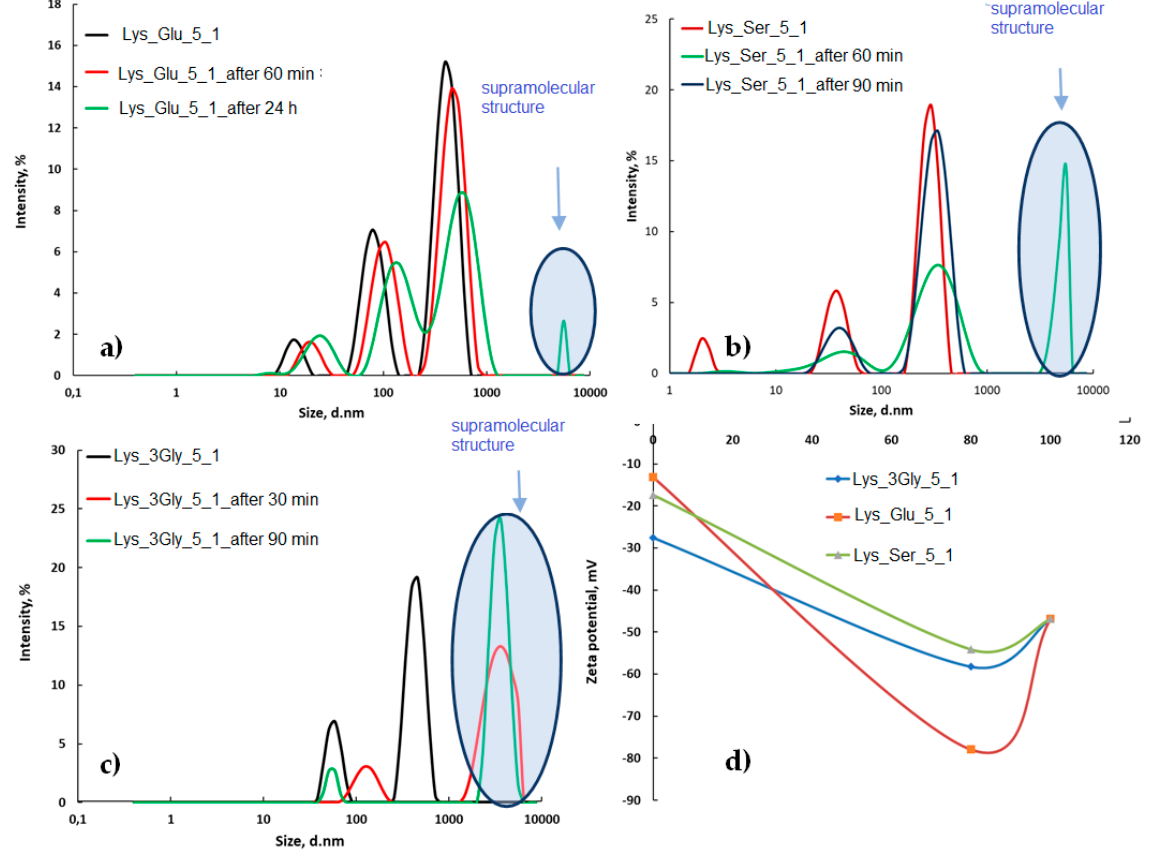
Figure 3. Size variation with time for ( a ) Lys_Glu_5_1, ( b ) Lys_Ser_5_1, ( c ) Lys_3Gly_5_1, and ( d ) zeta-potential variation of the co-assembled structures compared to the starting compounds.